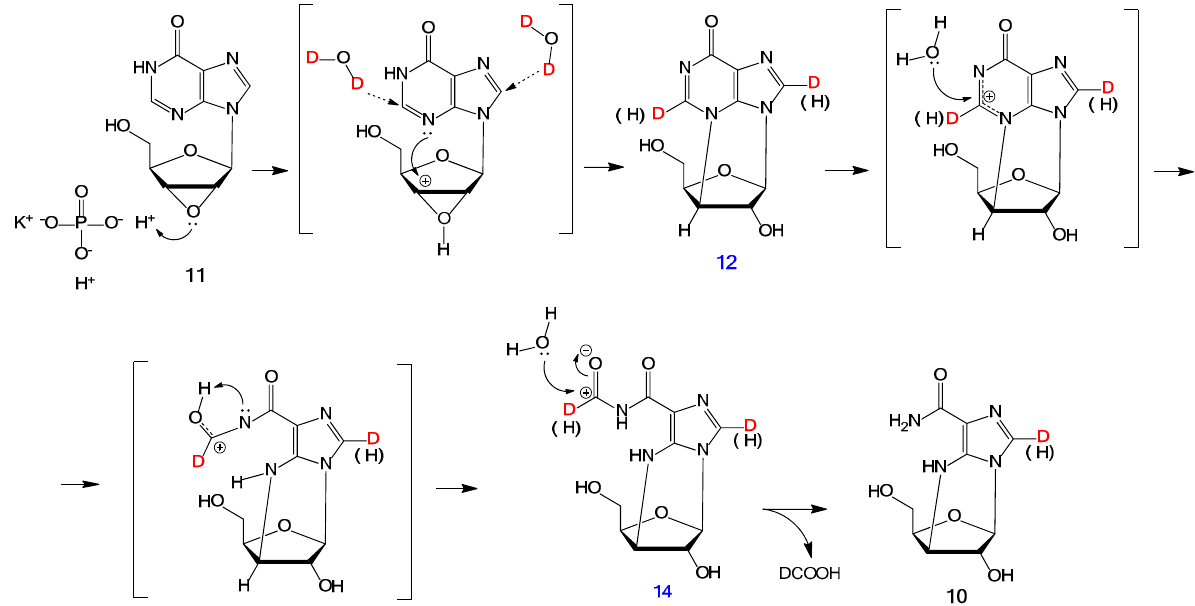
Scheme 3. A possible mechanism of hydrolysis of epoxide 11 with transient states and intramolecular rearrange- ments.